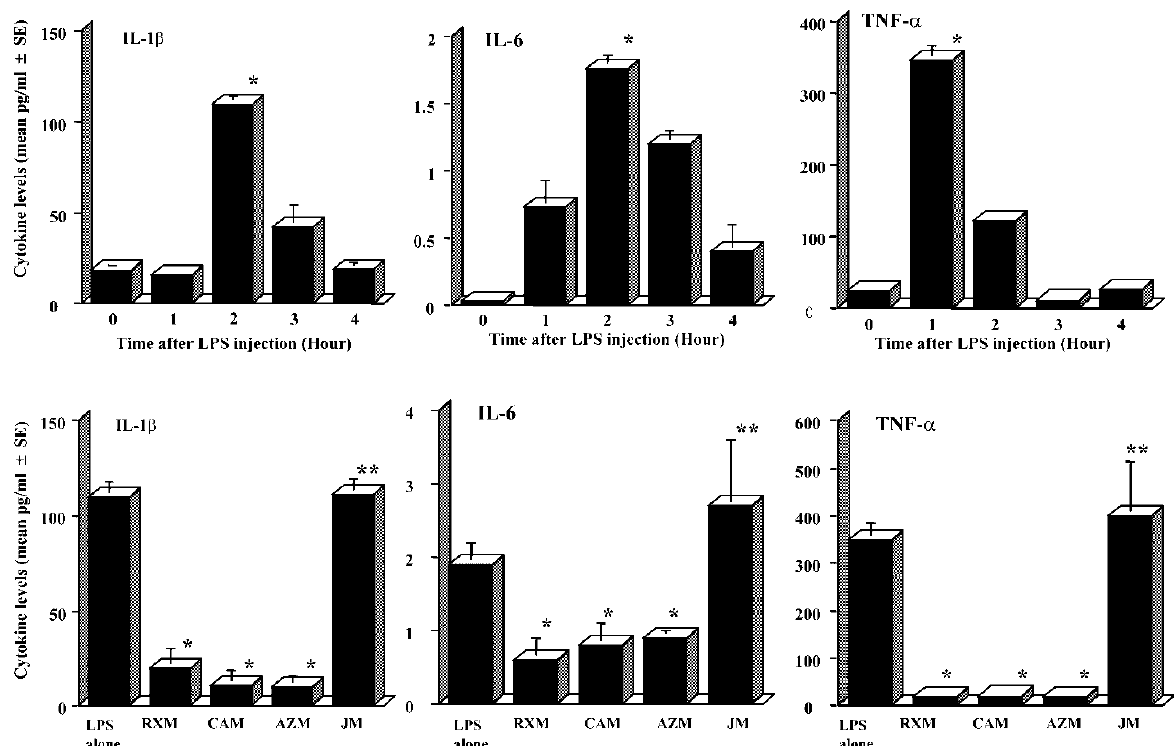
FIG. 5. Influence of macrolide antibiotics on pro-inflammatory production in response to LPS injection. ICR mice were administered orally with either RXM, CAM, AZM, or JM once a day for 4 weeks. The mice were then injected intraperitoneally with 5.0 mg/kg of LPS, and plasma cytokine levels were examined. Upper panels, the time course responses of cytokine productions, expressed as the mean (pg/ml) 9 / standard error of five mice. *Significant as compared with cytokine level before LPS injection. Lower panels, the influence of macrolide antibiotics on cytokine productions. IL-1 b and IL-6 levels in plasma were examined 2 h after LPS injection. The TNF- a level in plasma was examined 1 h after LPS injection. Data expressed as the mean (pg/ml) 9 / standard error of five mice. *Significant as compared with LPS alone; **not significant as compared with LPS alone.